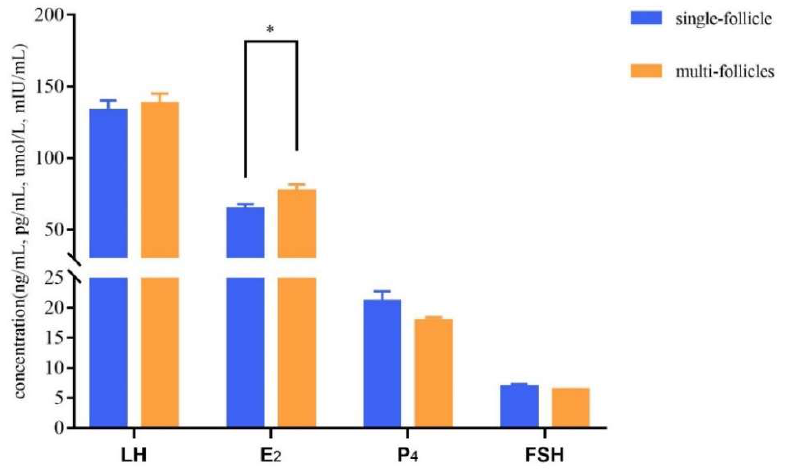
Figure 4. Concentrations of serum reproductive hormones. * p < 0.05.